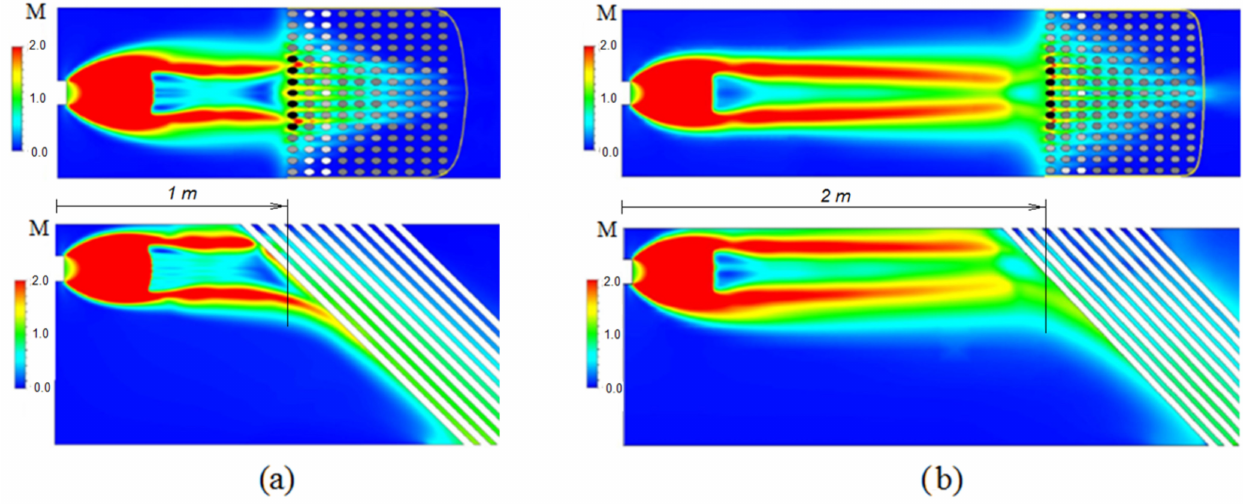
Figure 11. Blowing of the tube package by an air jet with pressure P 0 = 2.35 MPa. ( a ) Case 12; and ( b ) case 16. Upper—XOY plane, lower—XOZ plane.